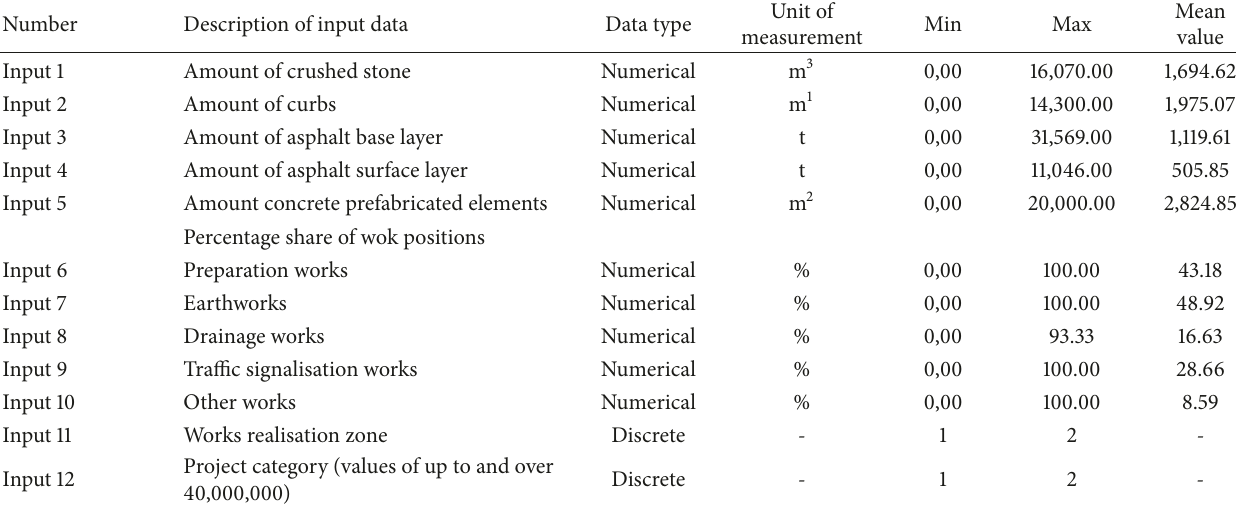
Table 4: Inputs into